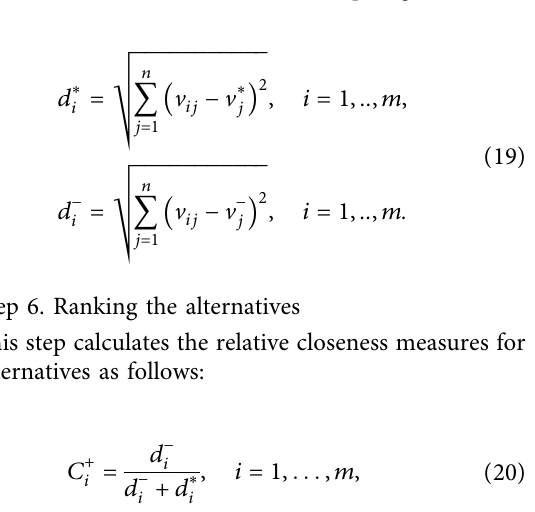
Figure 3: Comparing TFNs when interchanging their third